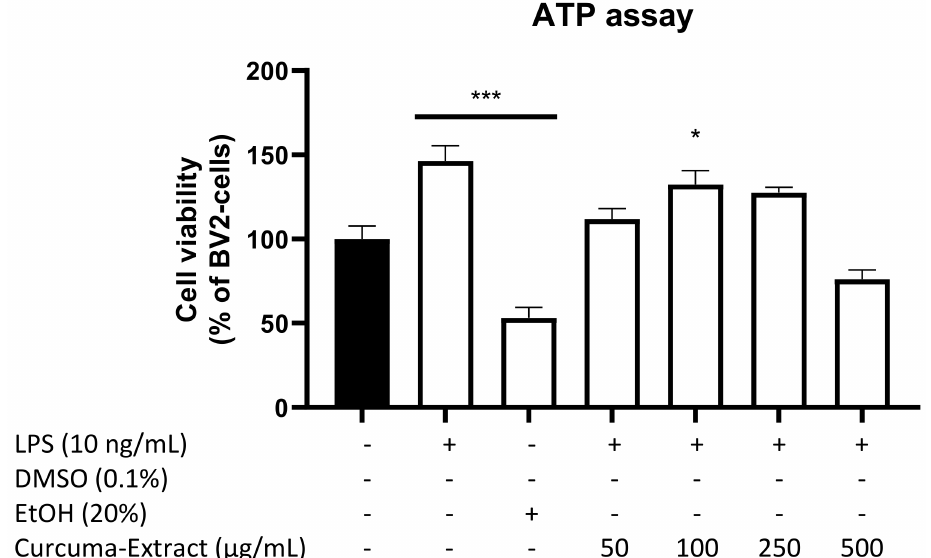
Figure 1. Effects of TE on cell viability of LPS-stimulated BV2 cells (ATP assay). TE was added 30 min before stimulation with 10 ng/mL LPS for 24 h. ATP levels and thus cell viability were measured by production of luminescent light following the firefly luciferase enzymatic reaction of Luciferin to Oxyluciferin using ATP. Values are presented as the mean ± SEM of four independent experiments. Statistical analysis was performed using one-way ANOVA with Bonferroni post hoc test and * p < 0.05 and *** p < 0.001, compared to untreated